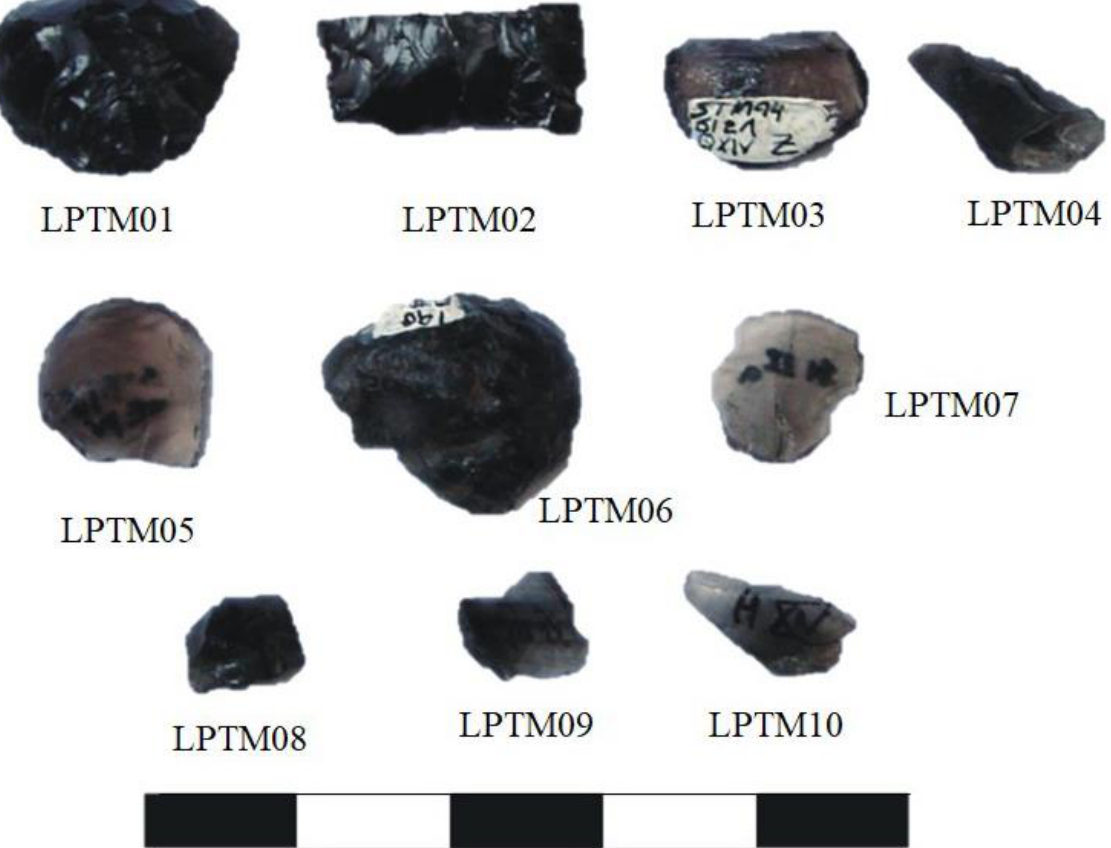
Figure 4. Obsidian artifacts from Tapera Moreira archaeological locality - Site 1. Scale bar = 5 cm (1 cm